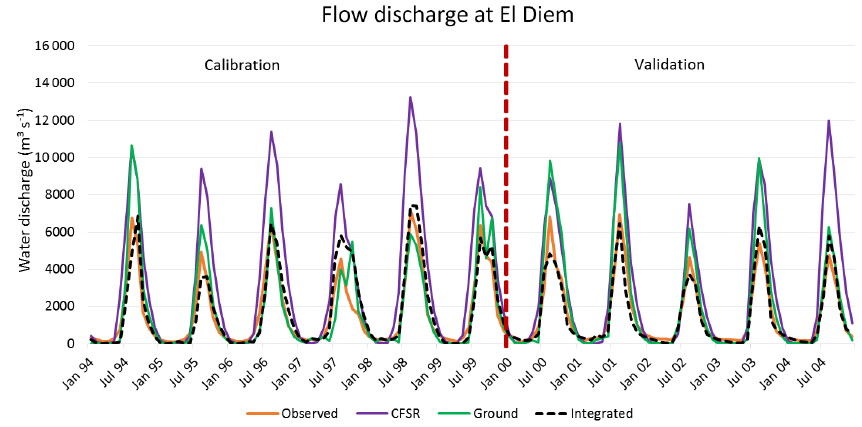
Figure 7. Calibration and validation of SWAT30 at El Diem. Calibration results achieved R 2 and NS values of integrated data: 0.88, 0.84; ground data: 0.86, 0.74; and CFSR data: 0.94, − 0.51, respectively. Validation results achieved R 2 and NS values of integrated data: 0.92, 0.91; ground data: 0.96, 0.45; and CFSR data: 0.92, − 0.48, respectively.